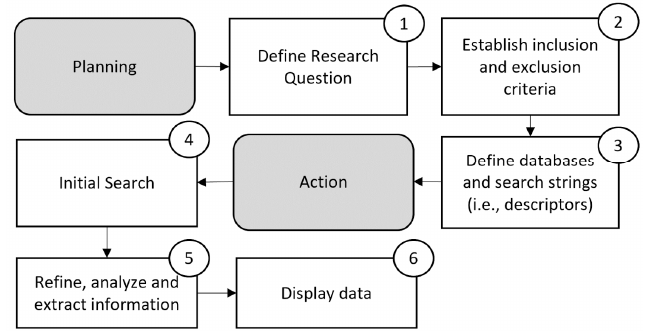
Figure 1. Flow chart. Source: Created by the authors.